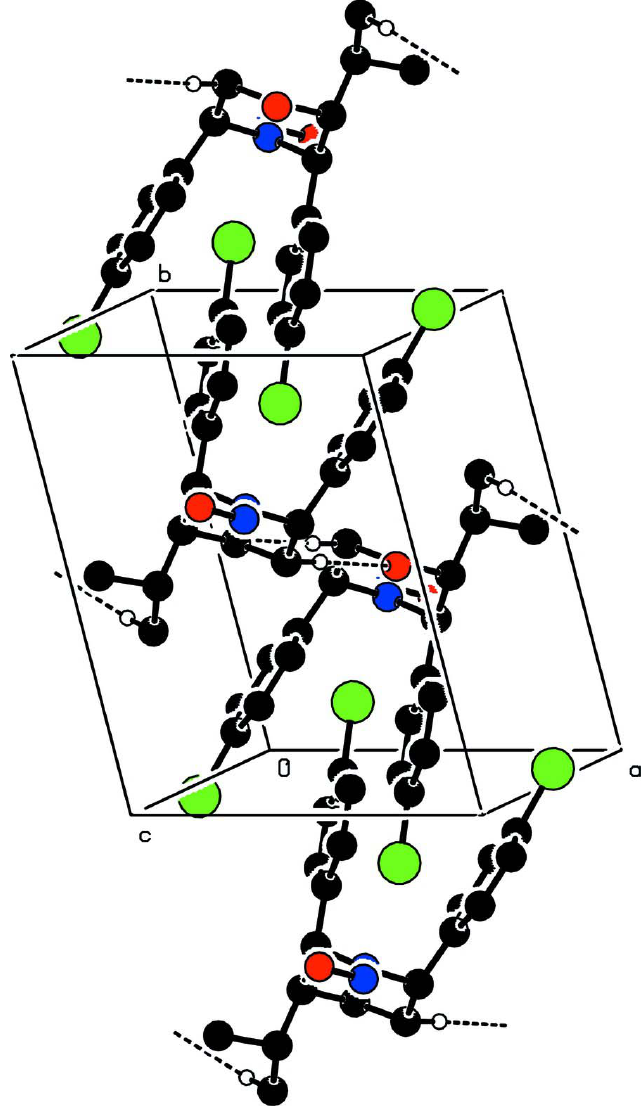
The packing of (I), viewed along the c axis. Dashed lines indicate hydrogen bonds. H atoms not involved in hydrogen bonding have been